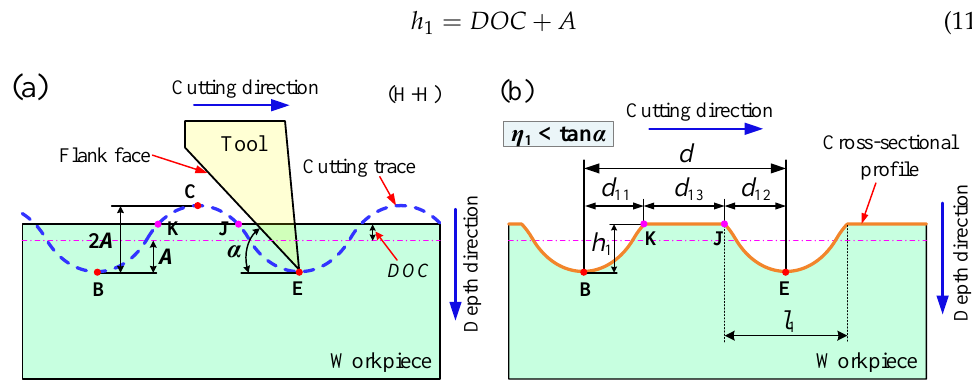
Figure 5. Flank face has no intersection with cutting trace ( η 1 < tan α ): ( a ) cutting trace; ( b ) cross- sectional profile of dimples.